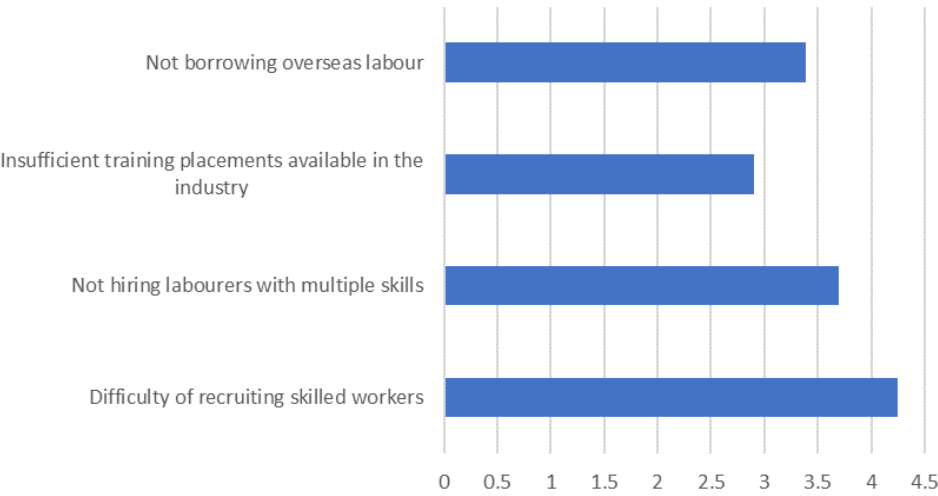
Figure 1. Skill issues in the prefabrication construction